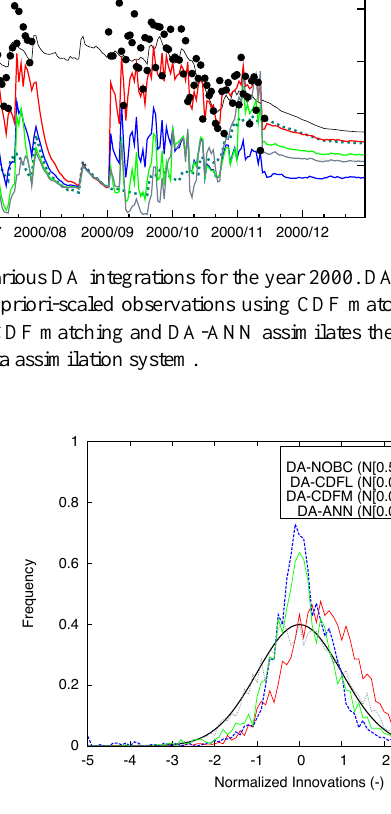
Figure 12. Distribution of normalized innovations from various DA integrations compared against the standard normal